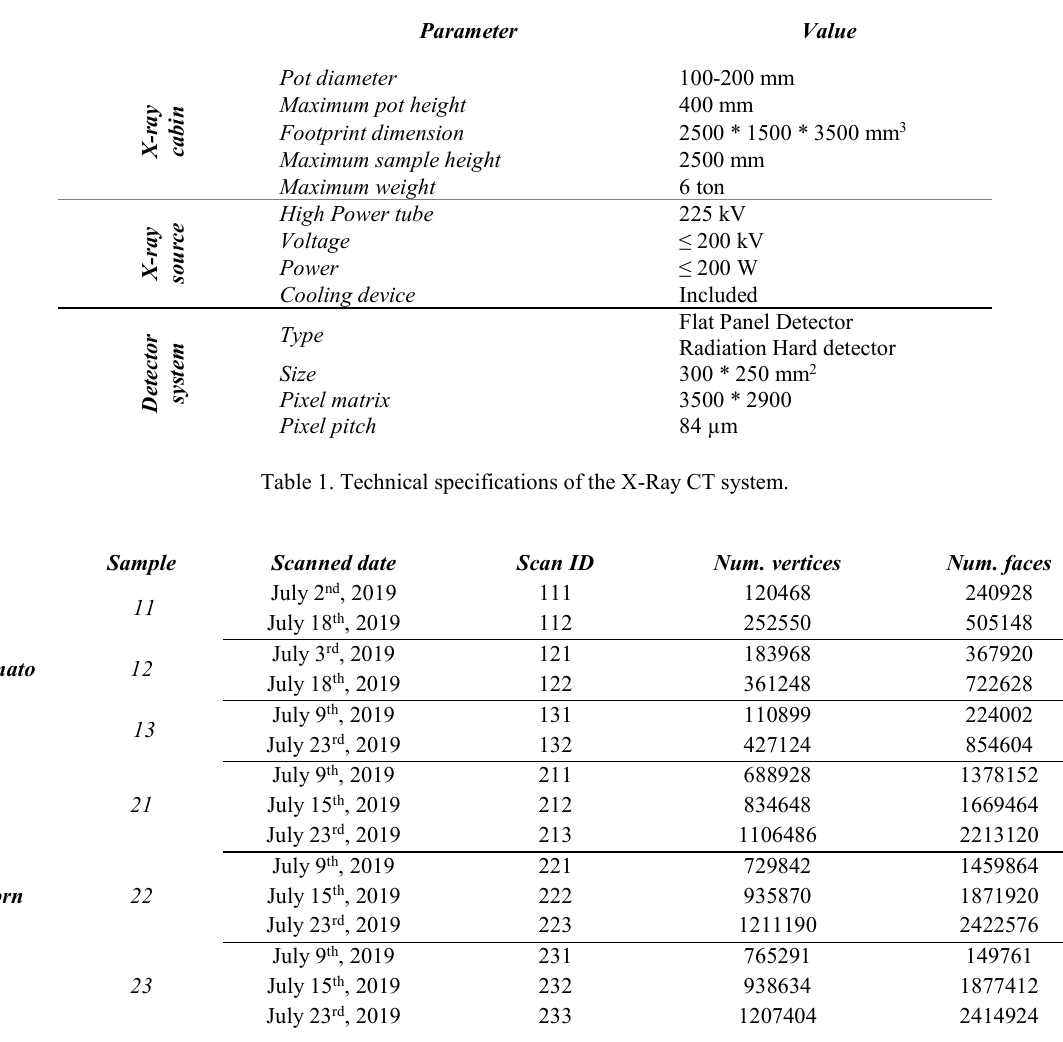
Table 2. Root digital twin